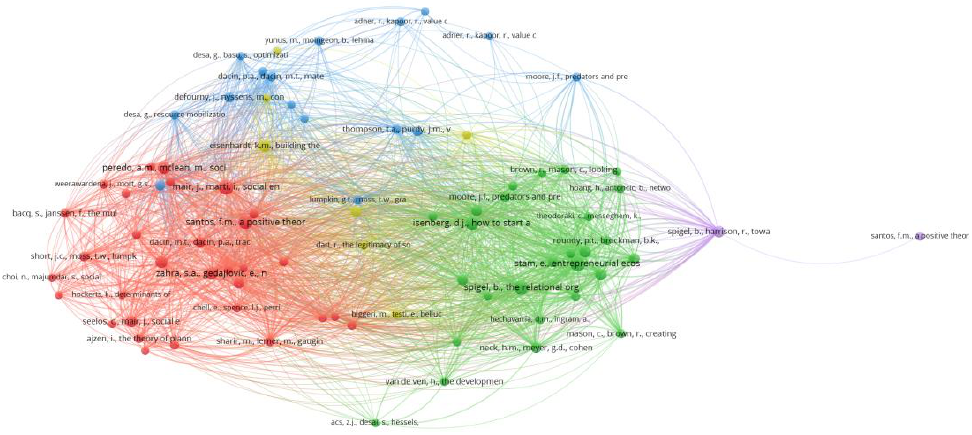
Figure 5. Co-citation network. Source: authors based on VOSviewer software.